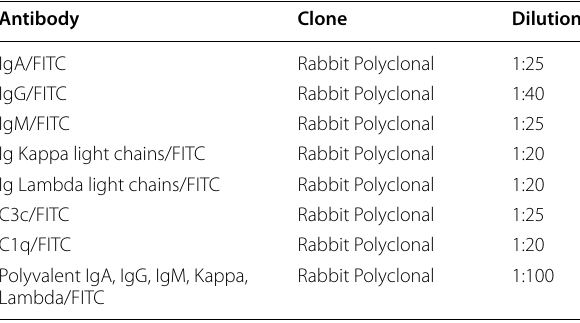
Table 1 Summary of antibodies’ clones and titration used in the study Antibody